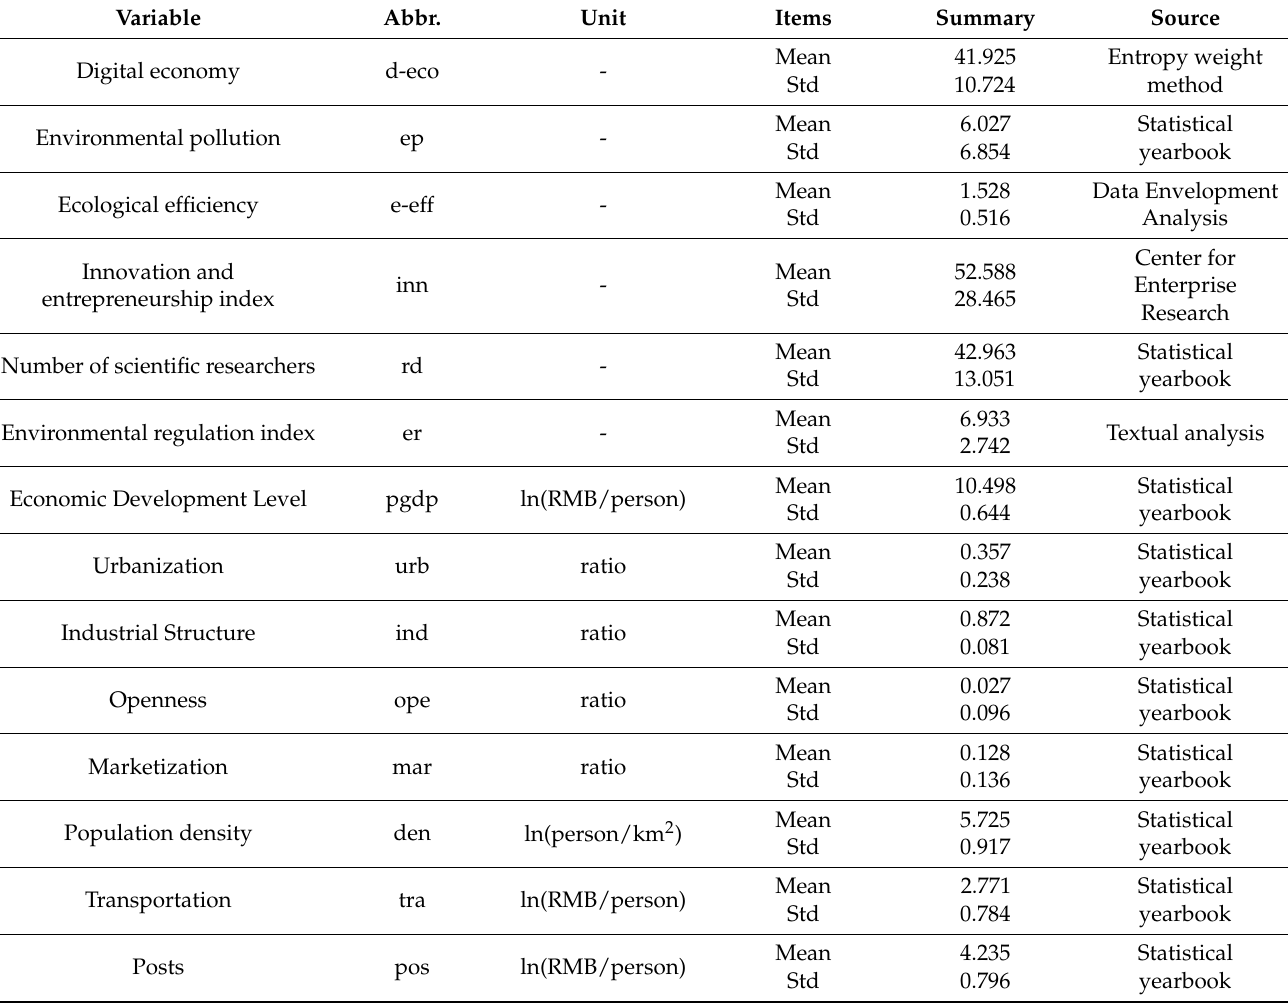
Table 2 lists the variables’ sources and descriptive statistics. Table 2. Data sources and descriptive